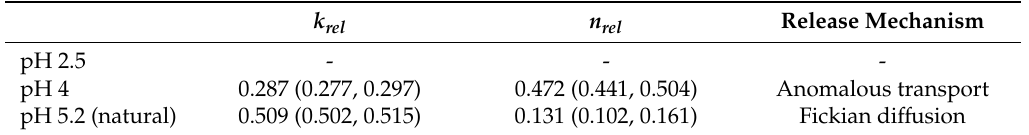
Table 3. Fitted parameters (95% CI) for the Korsmeyer–Peppas release model and release mechanisms